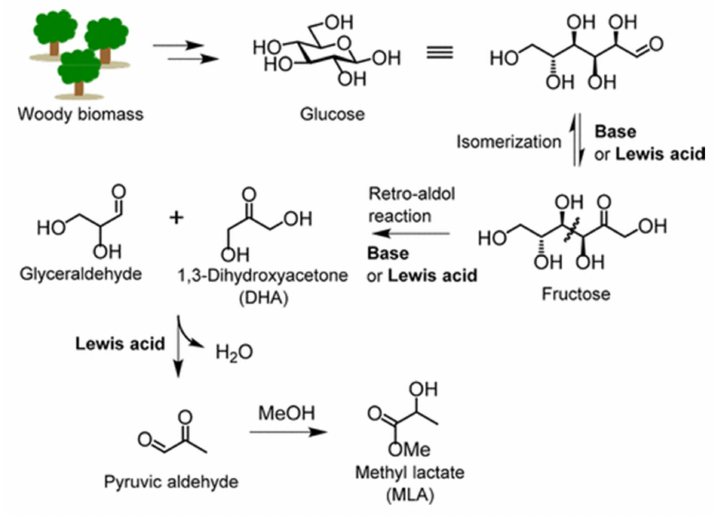
Figure 12. Reaction pathway for the conversion of glucose to methyl lactate. Reproduced with permission from [82]. Copyright 2018, American Chemical